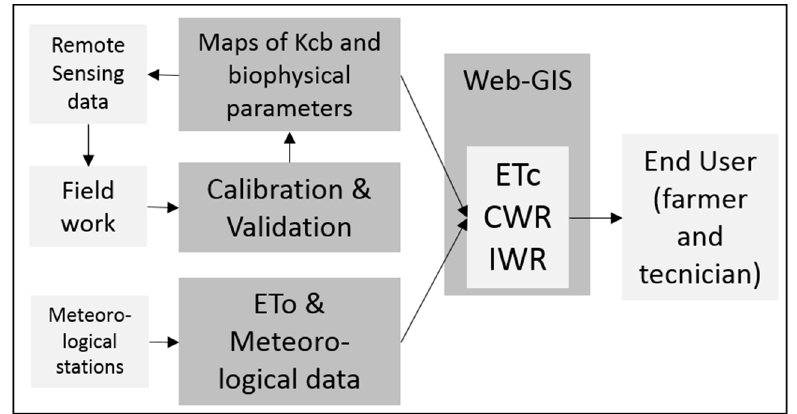
Figure 3. Scheme of the modular system based on the integration of remote sensing and weather observations into a web-GIS, to provide users with irrigation scheduling, matching the water supply to crop water demands. CWR, crop water requirements; IWR, irrigation water requirements.